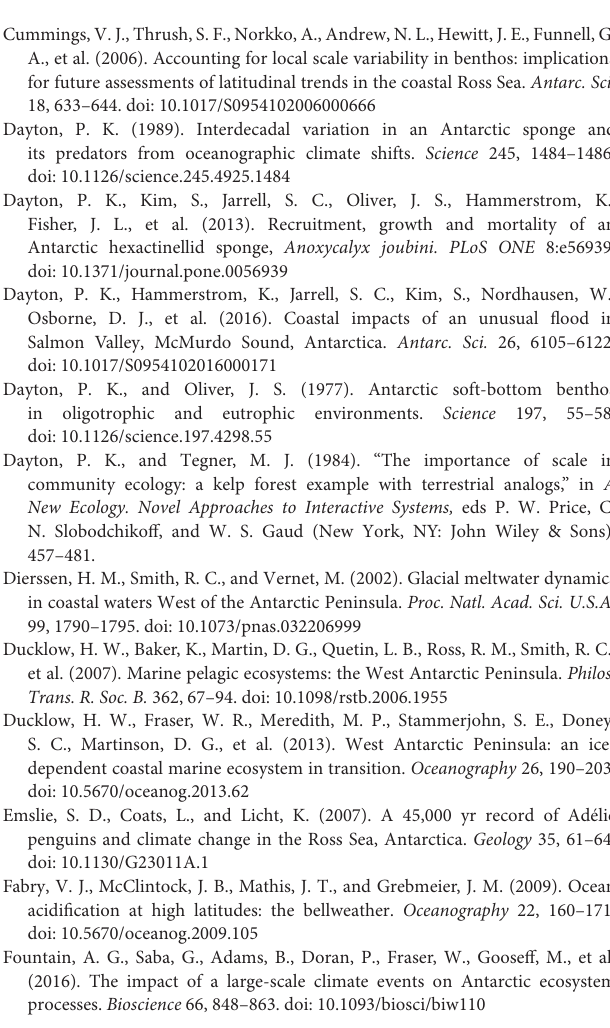
Supplementary Figure 1 | The proportion of the macrofaunal community exhibiting different types of functional traits at each site and location. (A) Feeding mode, (B) motility, (C) living position.